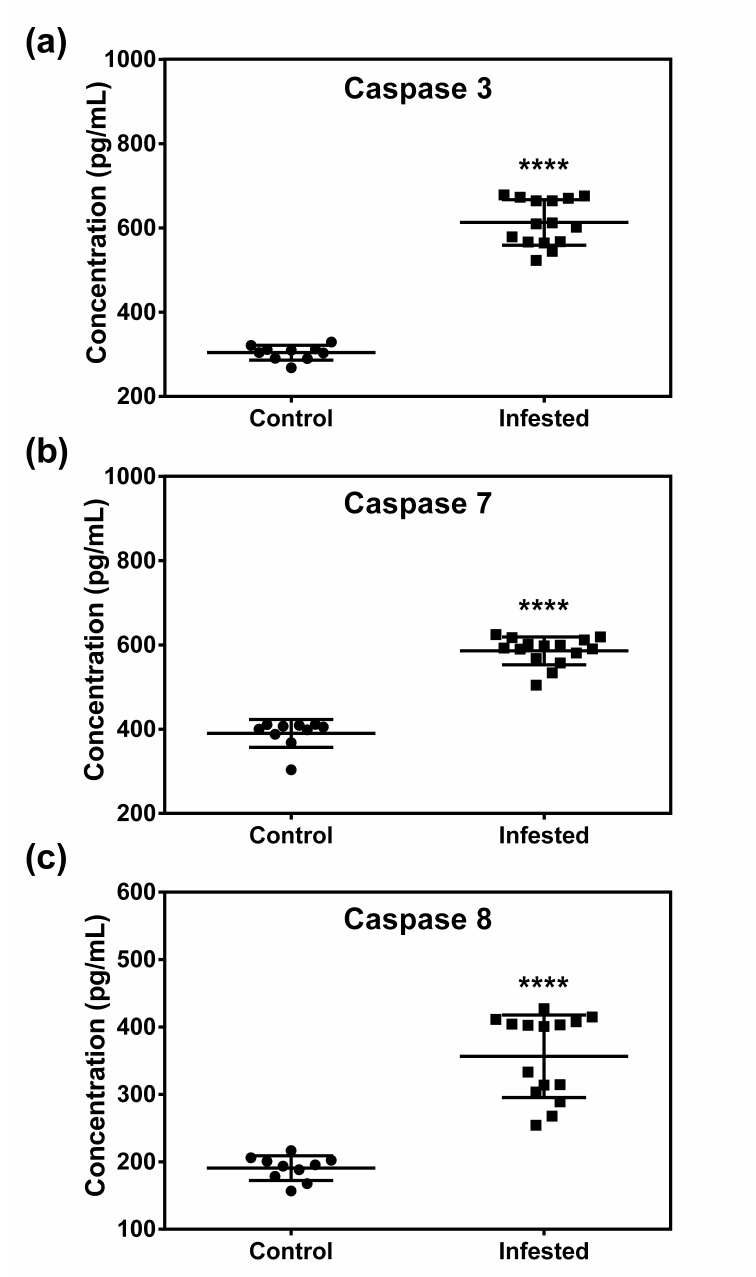
Figure 8. E ff ect of crusted scabieson serum levels of apoptotic markers in a porcine model. ( a ) Caspase 3, ( b ) caspase 7, ( c ) caspase 8. Data in scatter plot are shown as mean ± SD. t -test was performed to find out significant di ff erence between the two groups. **** denotes p ≤